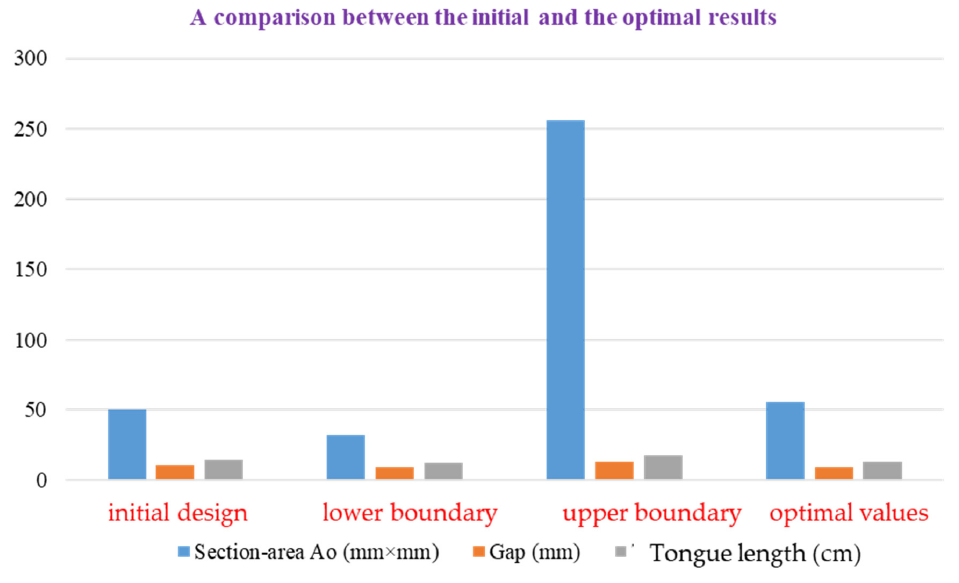
Figure 17. A results comparison of the initial and optimal design.